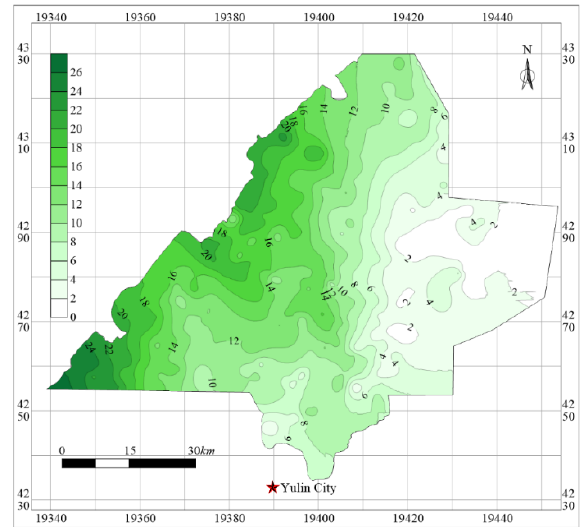
Figure 17. Maximum (theoretical) allowable mining height contour. (Xi’an geodetic coordinate system 1980; in km).